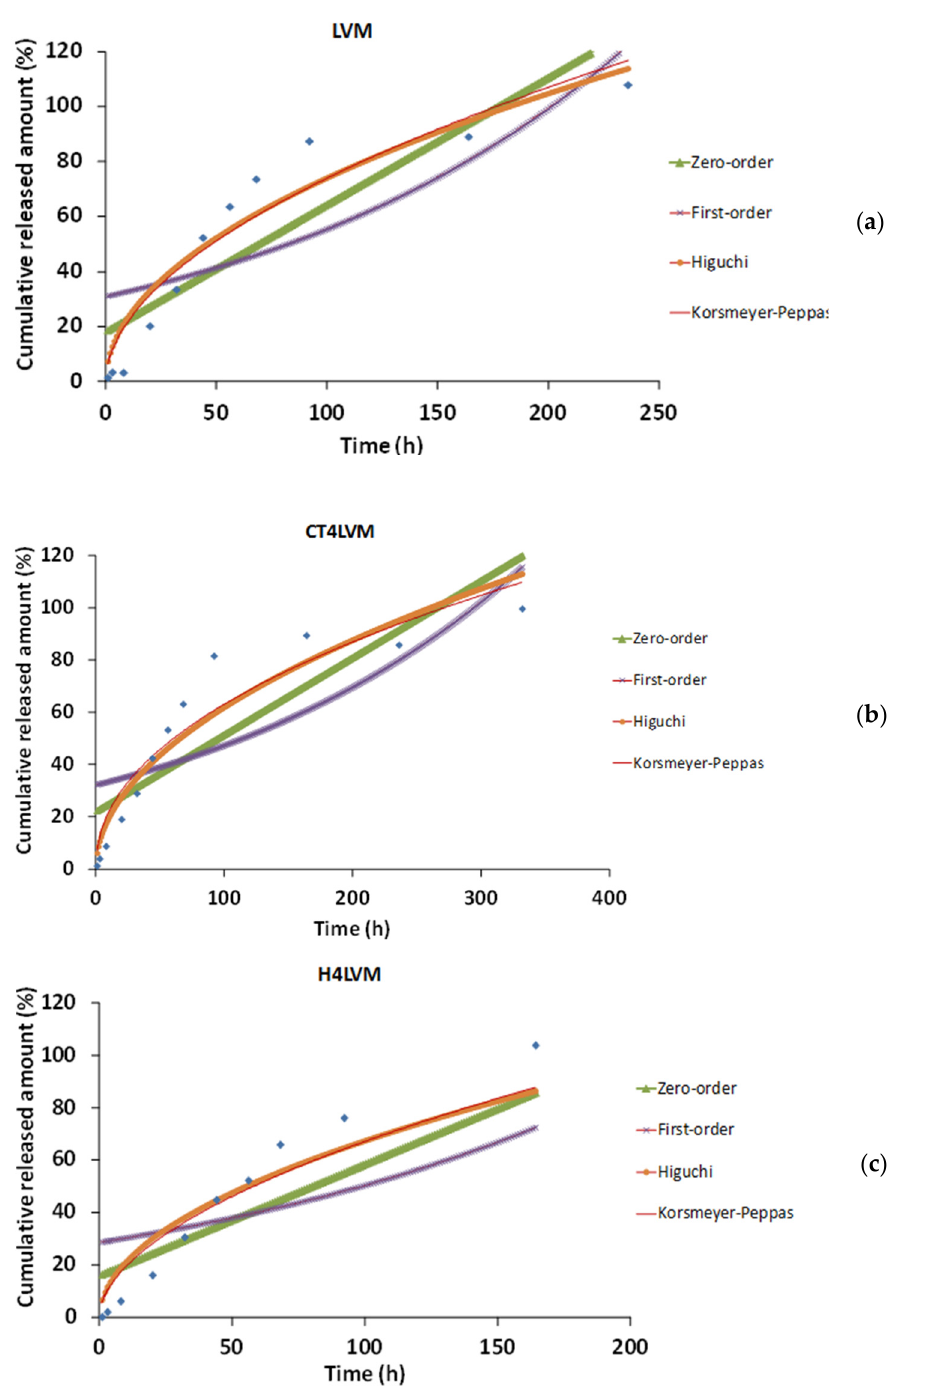
Figure 6. The mathematical models applied to the Curcumin release profile of LVM ( a ), CT4LVM ( b ), and H4LVM ( c ) (blue).